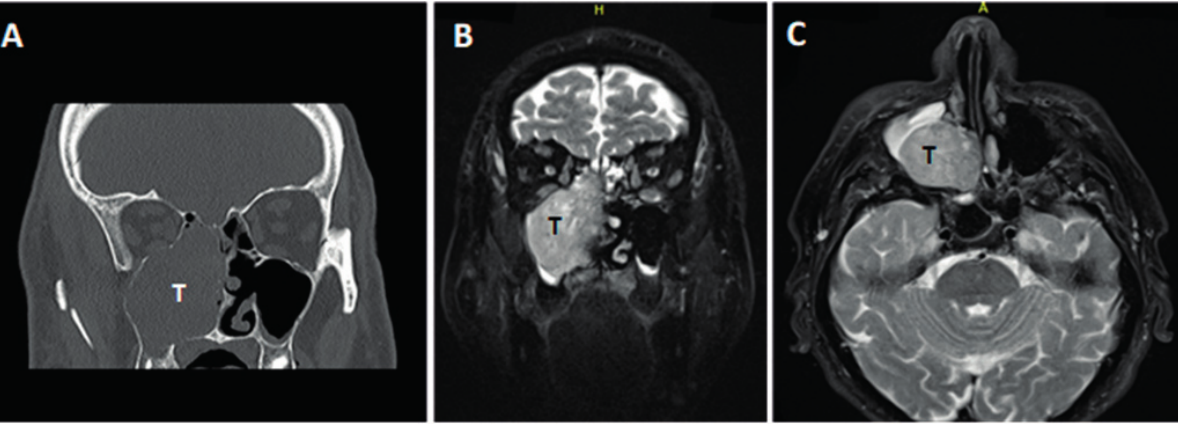
Fig. 2. Preoperative CT nad MRI scans of patient 2 show tumor mass in the right maxillary sinus. A – Preoperative CT scan, coronar reconstruction, bone window. B, C - Preoperative MRI, coronar (B) and axial (C) reconstruc- tions, both T2- weighted images. T –